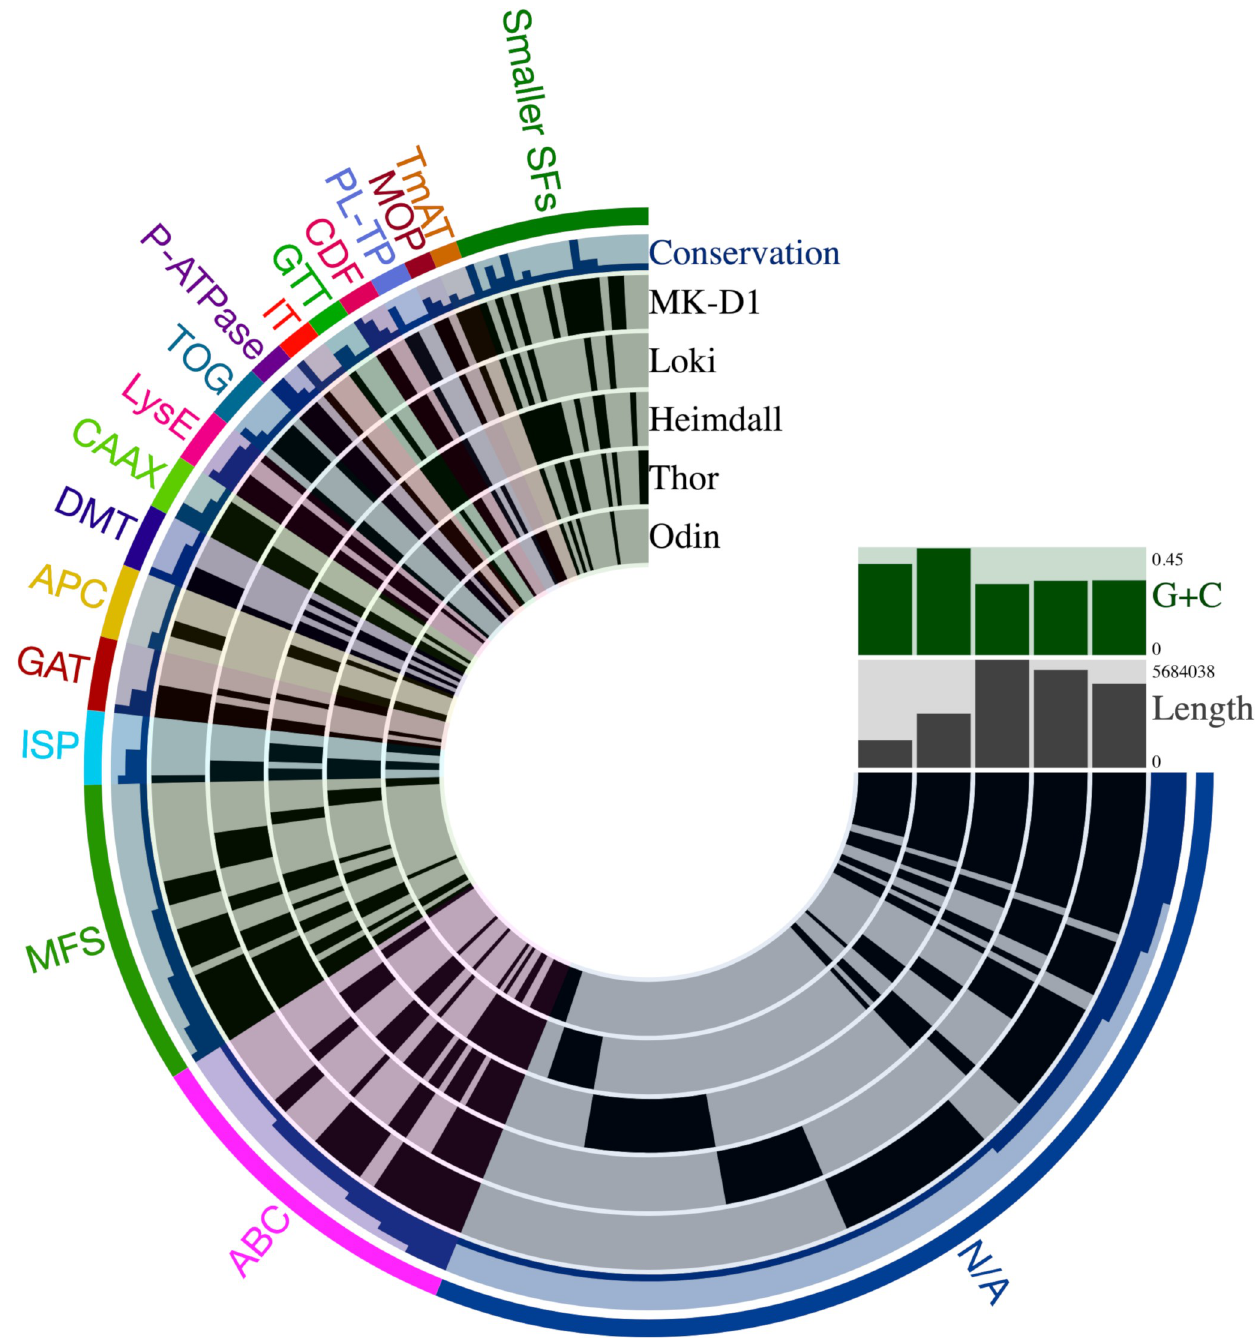
Fig 5. Conservation of superfamilies within five Asgard proteomes. TC Subfamilies were selected as the basic unit for counts across all proteomes. Black bars in the first five layers from the center indicate the presence of individual transport subfamilies. The patterns formed by these bars convey the presence or absence of individual subfamilies across proteomes. Blue bars in the sixth layer (Conservation) show the number of proteomes that contain at least one member of a particular subfamily. The outermost layer labels superfamilies as annotated in TCDB. Superfamilies are organized clockwise by decreasing size based on the number of different subfamilies the proteomes contain. Label “Smaller SFs” refers to superfamilies with fewer subfamilies. Label “N/A” denotes subfamilies not yet assigned to any superfamily. This figure was generated using Anvi’o [160, 161].